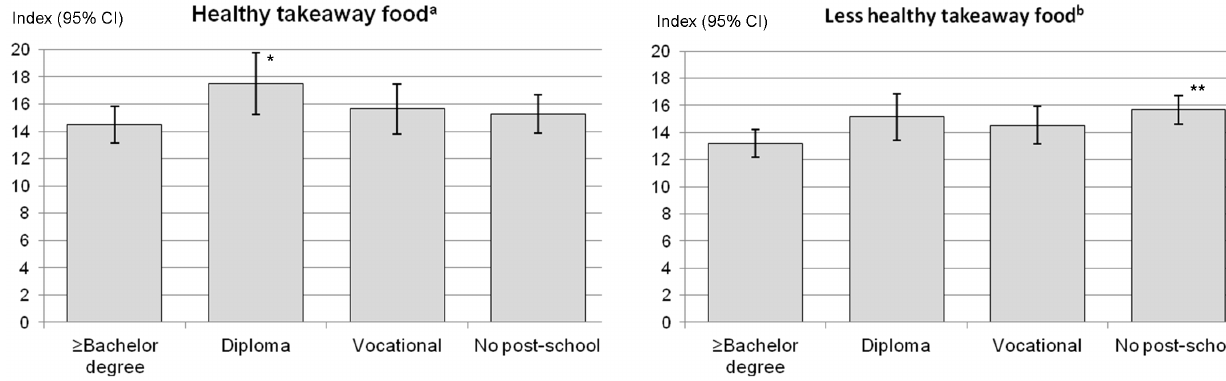
Figure 2. The average ‘‘healthy’’ and ‘‘less healthy’’ takeaway food consumption indices by education. The mean consumption values with their 95% confidence intervals. * p , 0.05, **p , 0.01 compared with participants with a bachelor degree or higher. All analyses adjusted for age and sex. a The ‘‘healthy’’ takeaway food consumption index (ranged from 0 to 100; mean 15.3, SD 11.7), with high score indicating a wide variety or greater frequency of consumption. P -for trend =0.512. b The ‘‘less healthy’’ takeaway food consumption index (ranged from 0 to 100; mean 14.0, SD 9.3), with high score indicating a wide variety or greater frequency of consumption. P -for trend =0.004. doi:10.1371/journal.pone.0108799.g002 PLOS ONE |